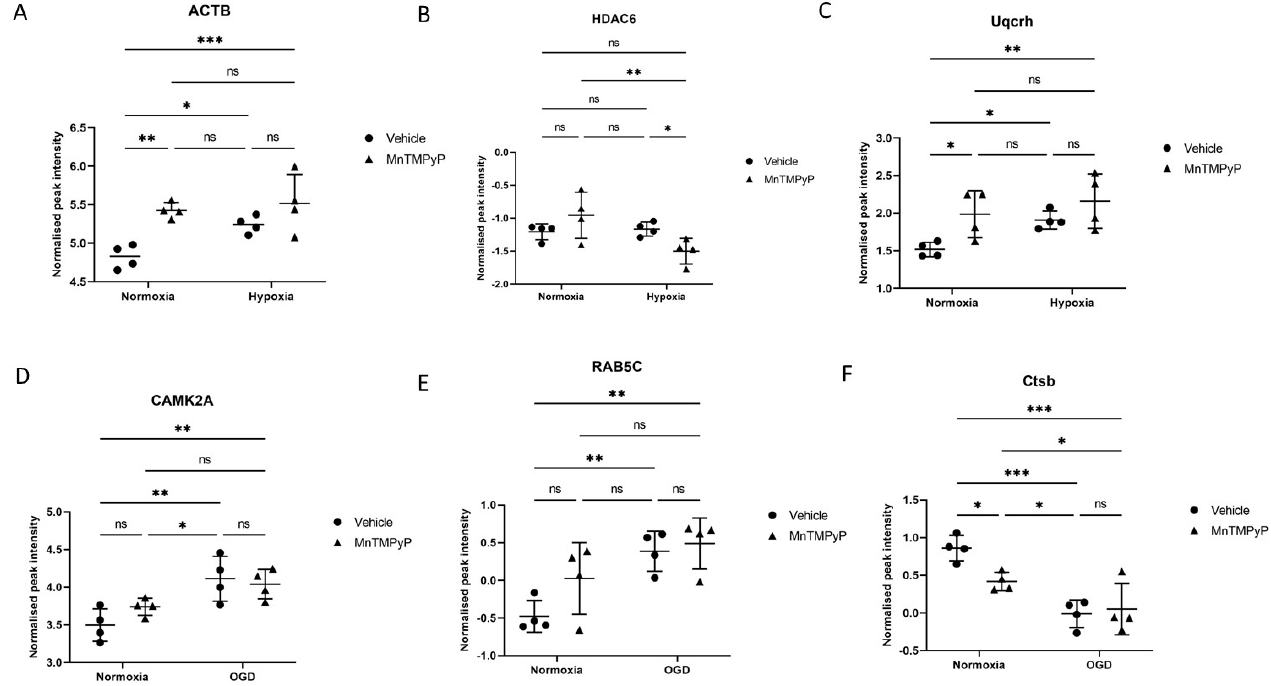
Figure 9. Two-way ANOVA analysis across hypoxia-treated and OGD-treated CA1 region replicates previously highlighted themes of plasticity, cell stress and mitochondrial change. Comparison